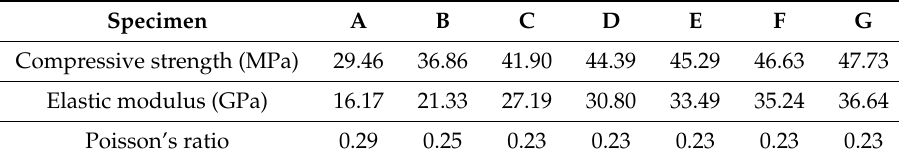
Figure 9. Influence of interfacial transition zones (ITZs) on the compressive behavior of ordinary concrete. Table 6. Influence of interfacial transition zones (ITZs) on the mechanical properties of ordinary concrete in